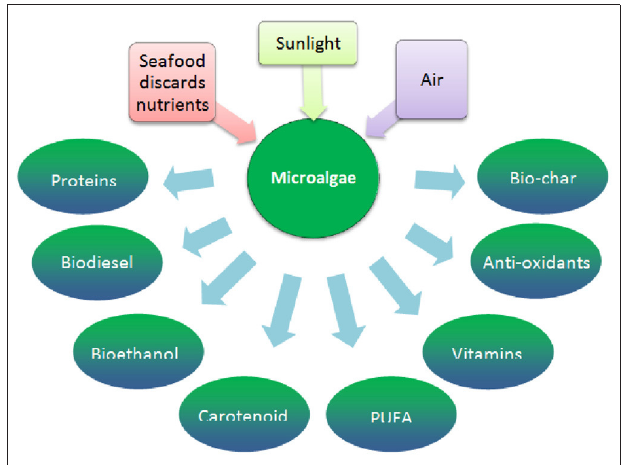
FIGURE 4 | Microalgae based bio-refinery for various products from seafood discards (adapted from Koyande et al., 2019).